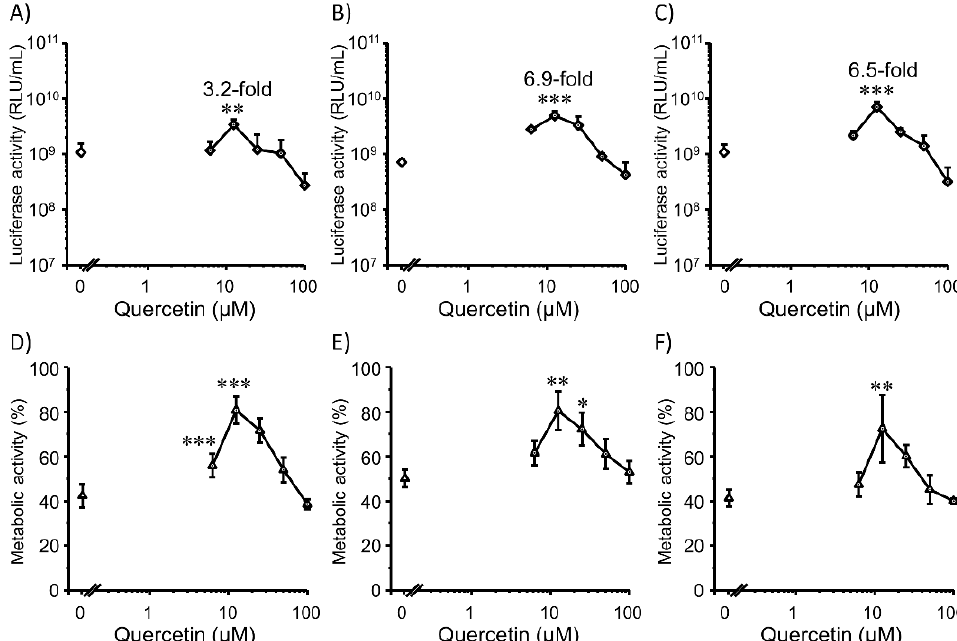
Figure 6. Effects of co-incubation with quercetin (0–100 µ M) at three different transfection timings after seeding cells for 4 h ( A , D ), 3 d ( B , E ), and 7 d ( C , F ) on transfection efficiency ( A – C ) and metabolic activity ( D – F ) mediated by Lipofectamine 3000/plasmid DNA (pcDNA3/GL 0.2 µ g/well) complexes in 3D HepG2 cells. Each dot represents the mean ± SD ( n = 3). * p < 0.05, ** p < 0.01, *** p < 0.001 compared with the control (0 µ M quercetin).